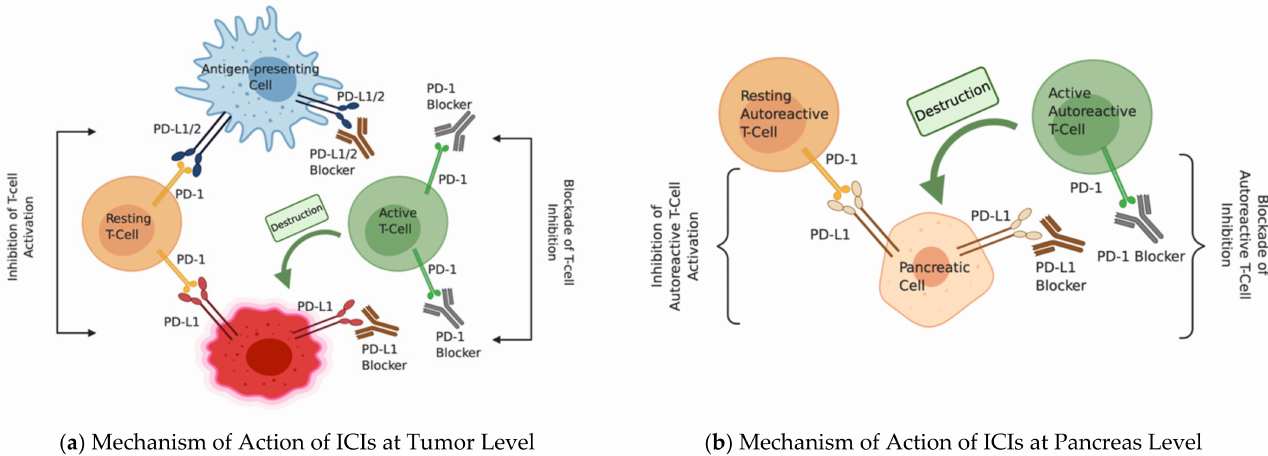
Figure 1. Proposed mechanism of action of ICIs at tumor and pancreas level. Proposed mechanism of action of PD-1/PD-L1 pharmacological blockade: ( a ) on the target tumor cell, and ( b ) on the pancreatic islet cell. ( a ) The antigen presenting cell (APC) presents the tumor antigen to the T cells. However, (to the left) T-cell activation in the tumor environment is inhibited by the binding of PD-1 to either PD-L1/2 on the APC or the PD-L1 on the tumor cell surface, and T cells remain in resting state. In the presence of anti-PD-1/PD-L1 antibodies (to the right), which bind and block this inhibitory pathway, T-cell activation and proliferation are both possible, and active T cells can destroy the tumor. ( b ) Since PD-L1 is also expressed by pancreatic islet cells, activation of autoreactive T-cells is inhibited via the PD-1/PD-L1 interaction (to the left). However, in the presence of anti-PD-1/PD-L1 antibodies blocking this interaction (to the right), autoreactive T-cells are activated, which leads to destruction of pancreatic islet cells and immune checkpoint inhibitor-induced diabetes. Created with